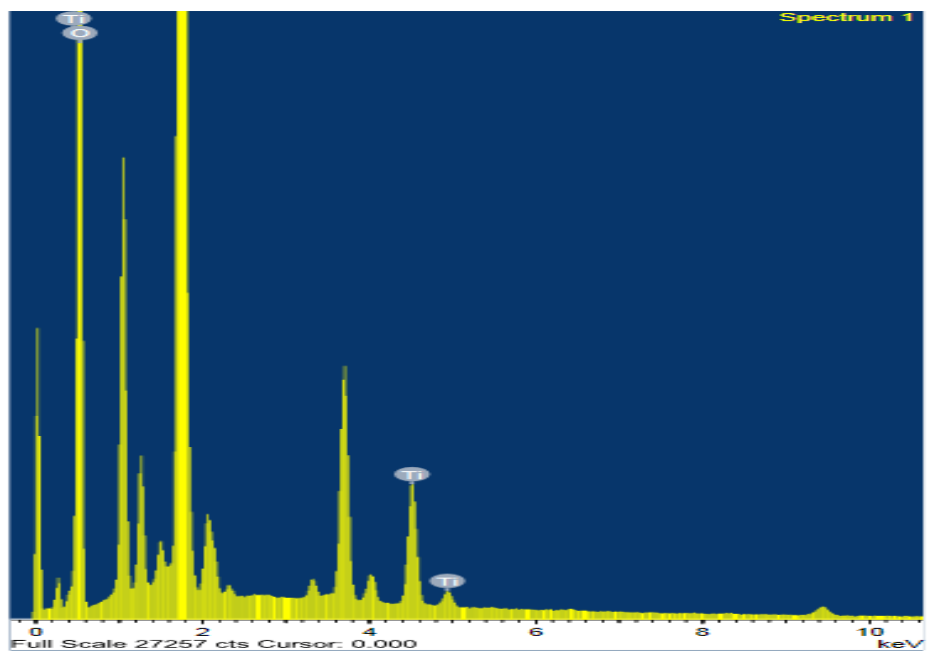
Figure 4. Energy ‐ dispersive spectroscopy results showing the chemical composition of the green Figure 4. Energy-dispersive spectroscopy results showing the chemical composition of the green TiO 2 nanoparticles. TiO 2 nanoparticles.